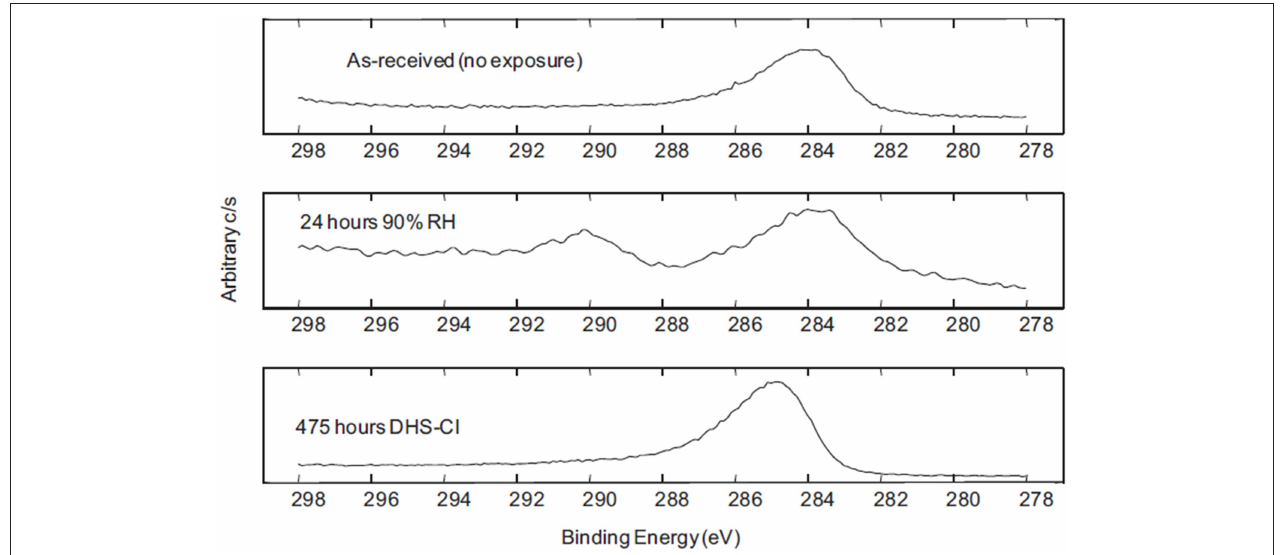
FIGURE 9 | X-Ray Spectroscopic analysis results demonstrating the development of C(1s) peaks over time of exposure in different simulated atmospheric conditions on the surface of a MgRP ( Francis, 2013). Reproduced with